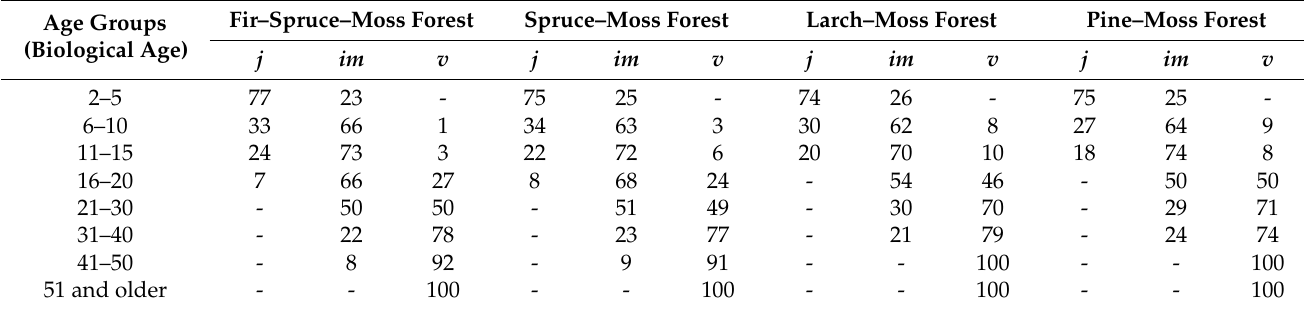
Table 3. The distribution of the undergrowth of Siberian spruce ( Picea obovata Ledeb.) along ontogeny stages (% of the total amount of plants of this age